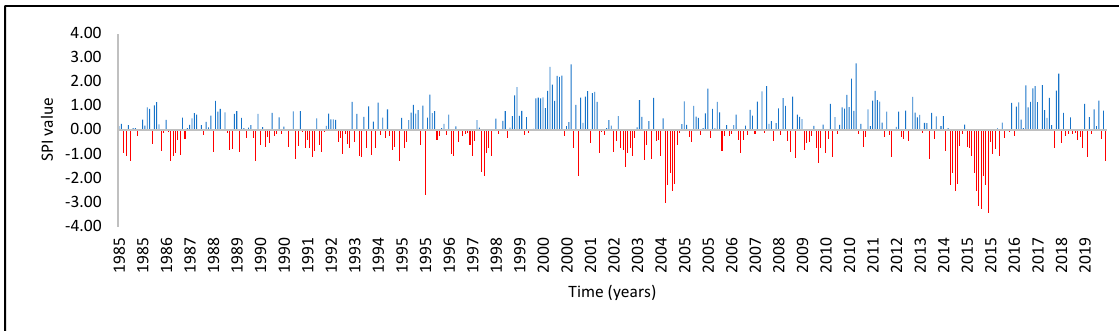
Figure 7. SPI time series, Rafael Bravo station in the period (1985–2019).